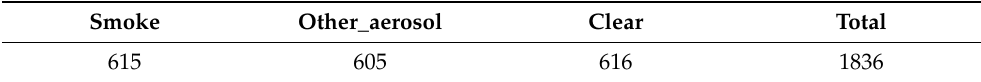
Table 6. Components of the Landsat